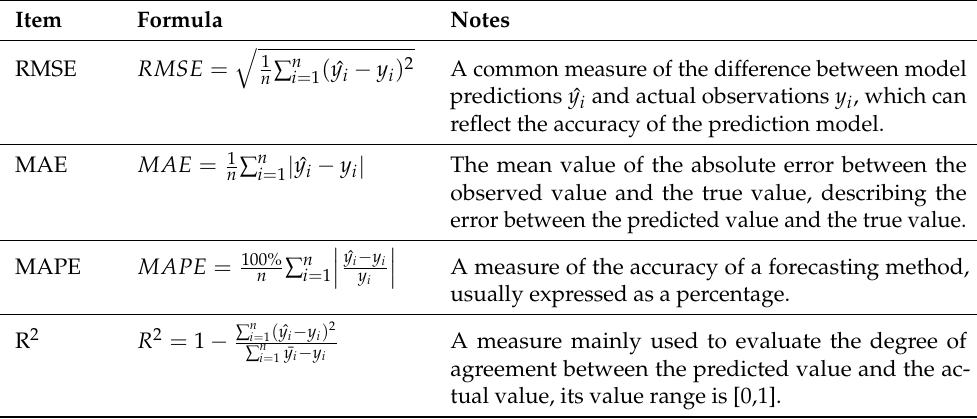
Table 1. Evaluation criteria for prediction performance of machine learning